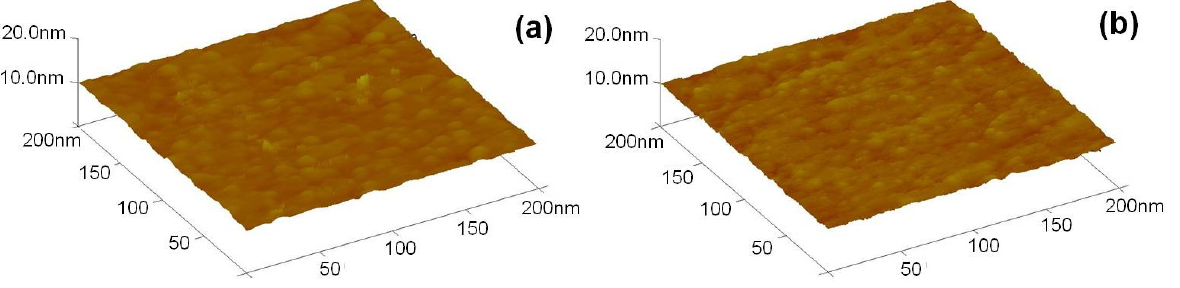
Figure 3. Surface Atomic Force Microscopy (AFM) morphology of IGZO thin films as a